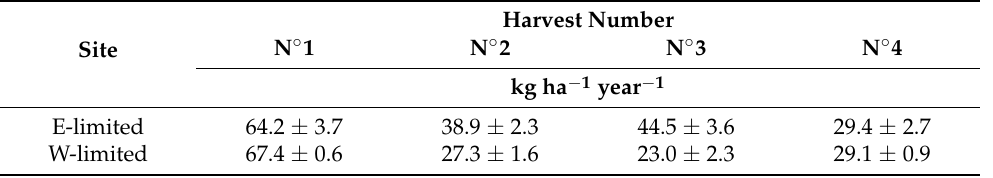
Table A6. Plant nitrogen uptake per harvest—mean values and inter-annual standard errors, ± , in kg ha − 1 year − 1 —for Rollesbroich soil in Rollesbroich, the energy-limited site (E-limited) and Selhausen, the water-limited site (W-limited) between 2012 and